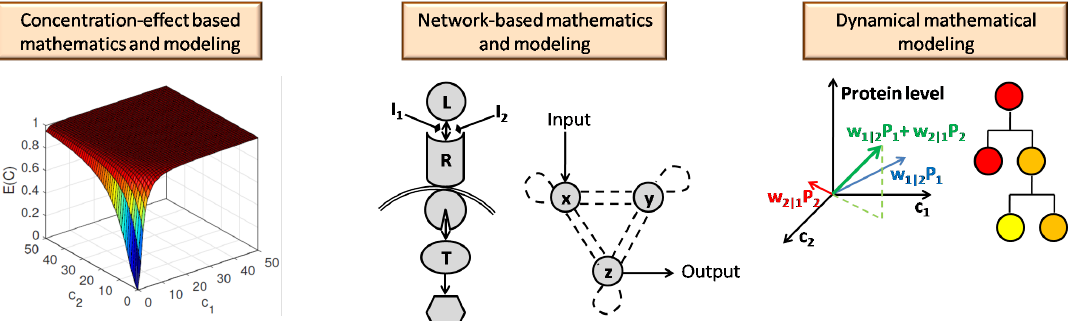
Figure 13. Leading mathematical methods that model drug